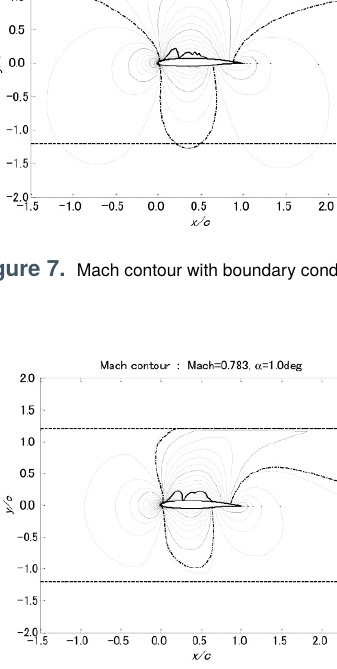
Figure 8. Mach contour with boundary condition